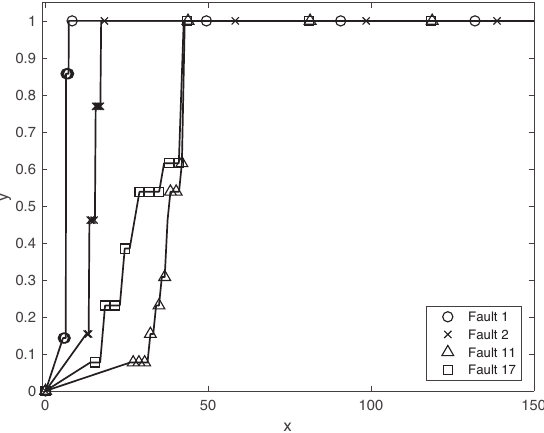
Figure 7. Cumulative density functions (CDFs) of fault detection delay of faults 01,02,11,17.